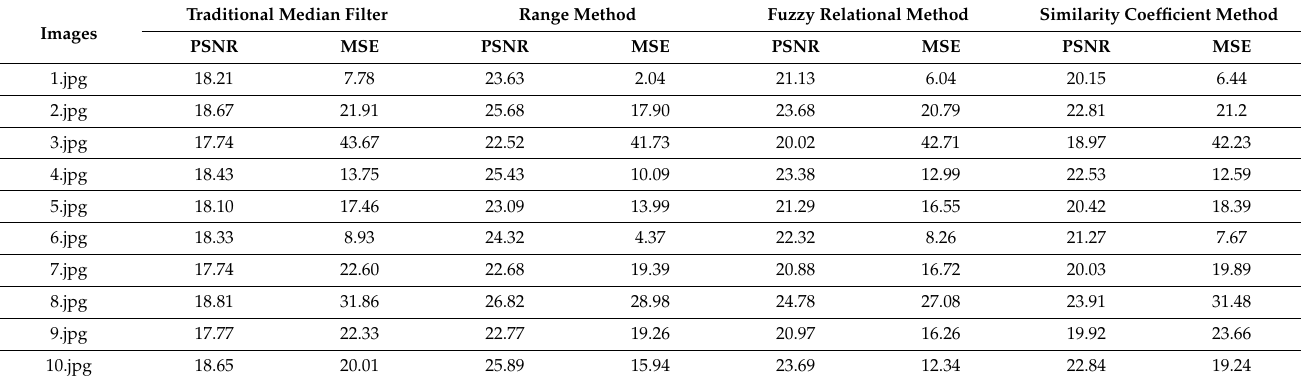
Table 2. Statistical analysis of the images with respect to their PSNR and MSE values.